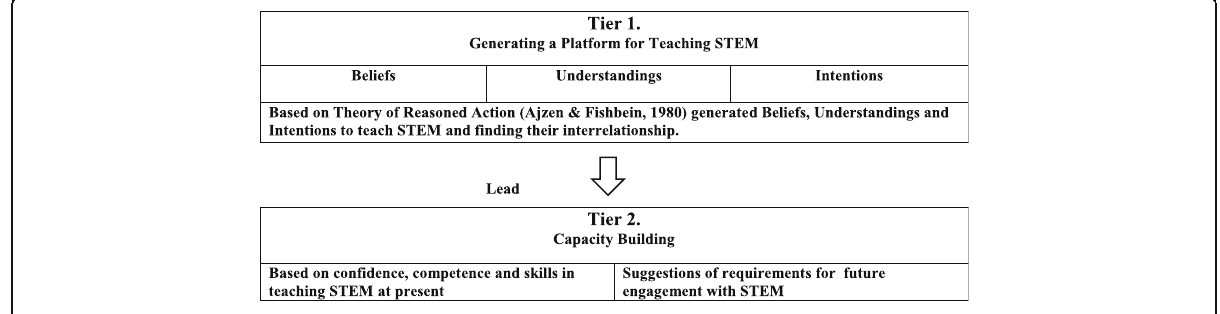
Fig. 1 Conceptual framework of future primary teachers ’ platform of capacity to deal with STEM in their future teaching